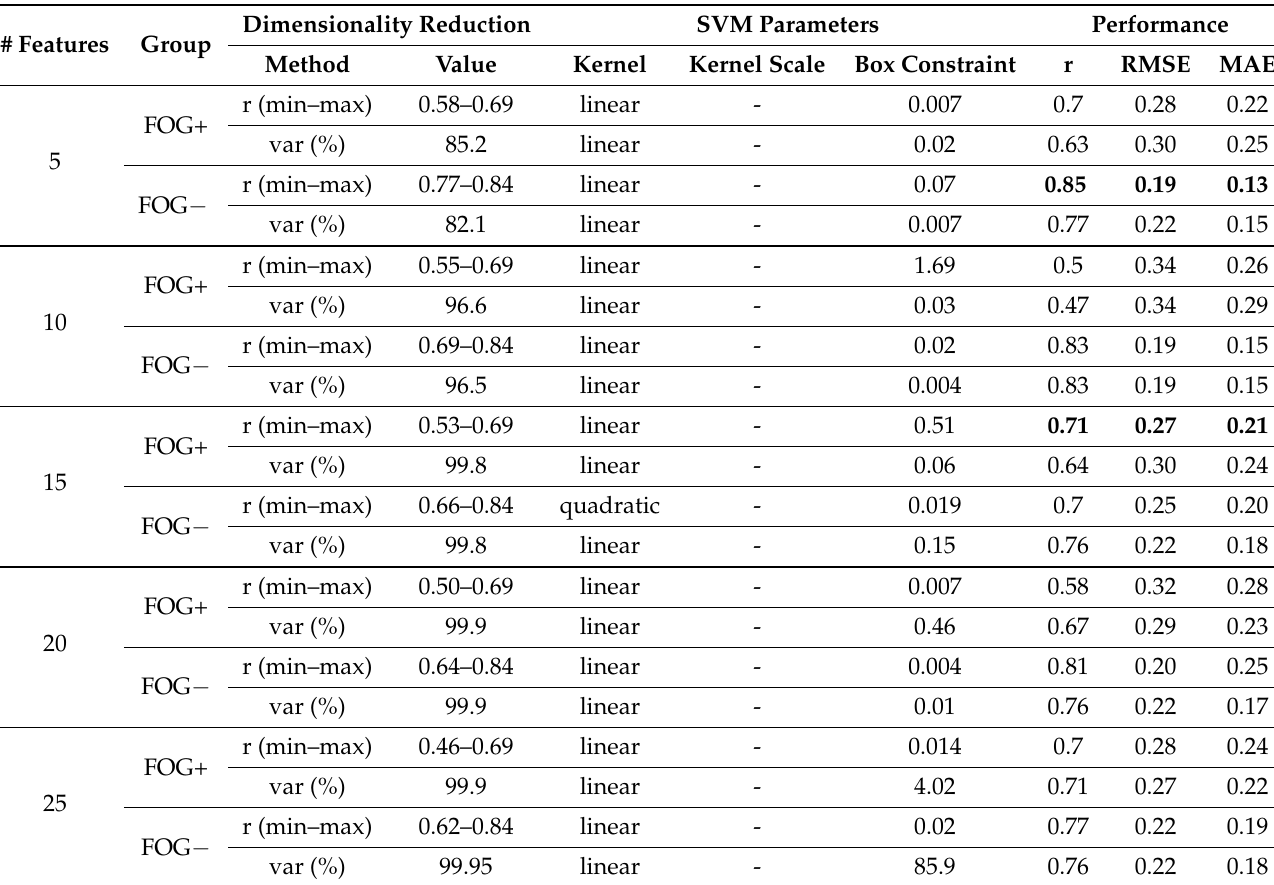
Table 9. Performance of regression models in patients with (FOG+) and without (FOG − ) freezing of gait, both under dopaminergic therapy. Results were obtained for different feature set size and different dimensionality reduction methods. Best performances are marked with bold type. RMSE: root mean square error; r: correlation coefficient; MAE: mean absolute